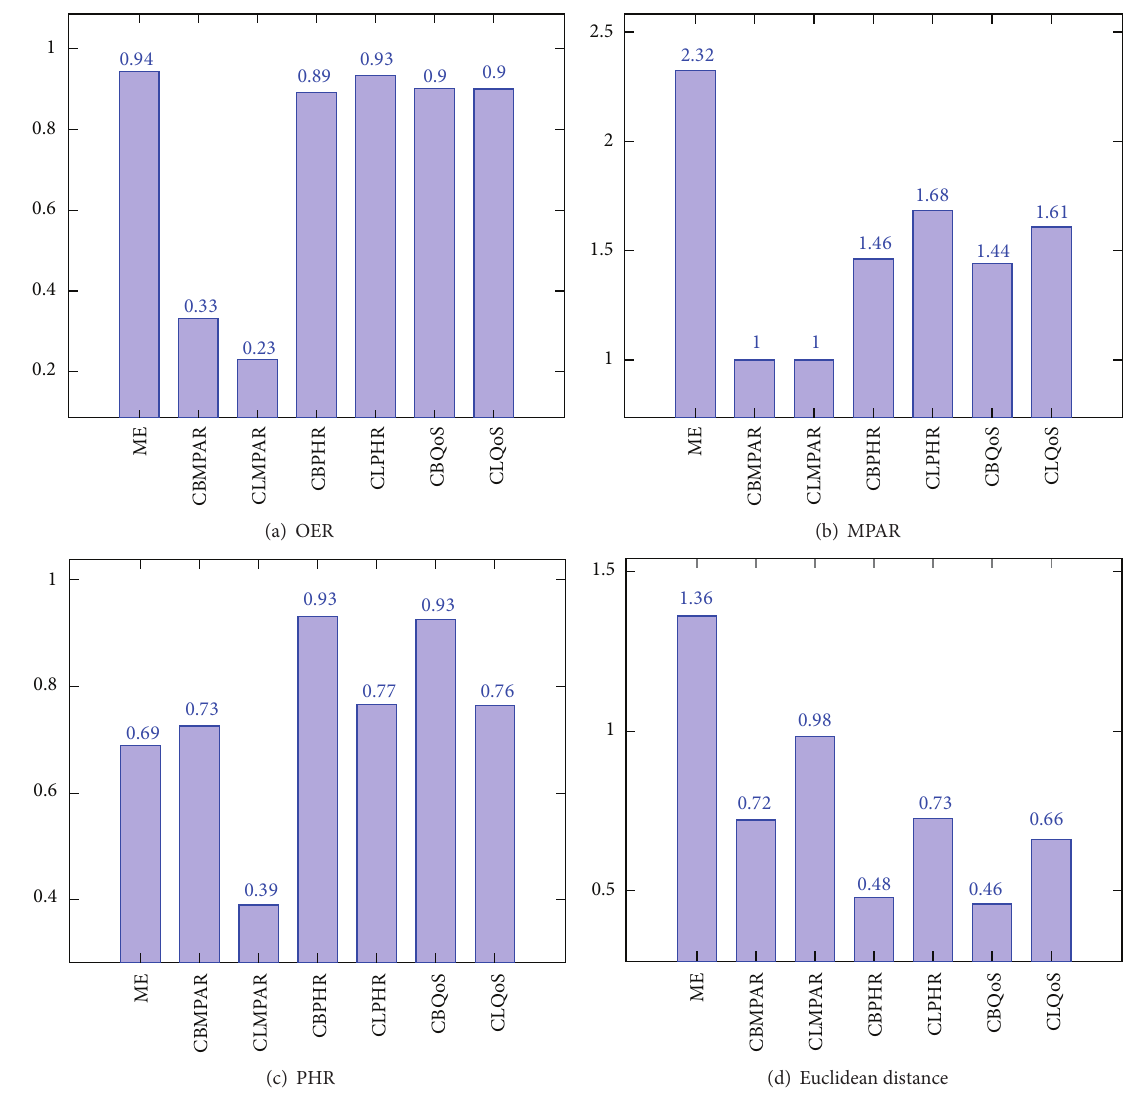
Figure 16: Performance assessment of optimisation